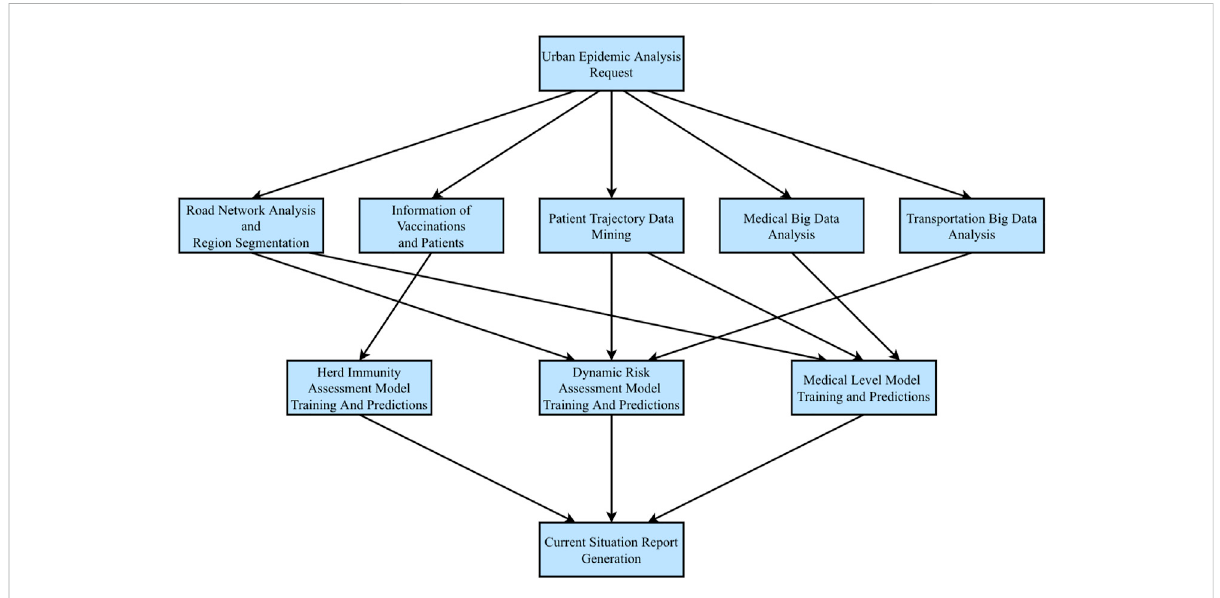
FIGURE 1 An work fl ow example of digital